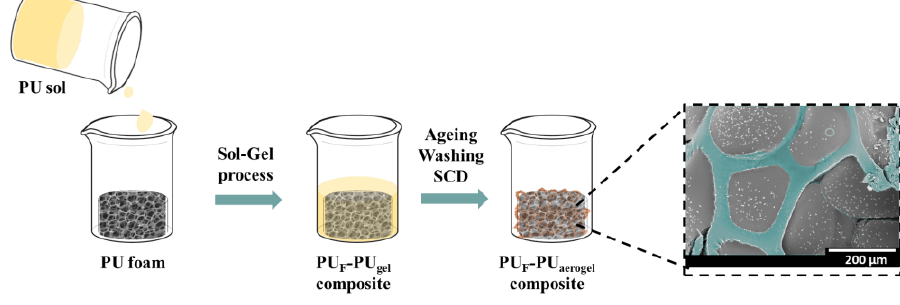
Figure 1. PU F – PU A synthesis procedure. Figure 1. PU F –PU A synthesis